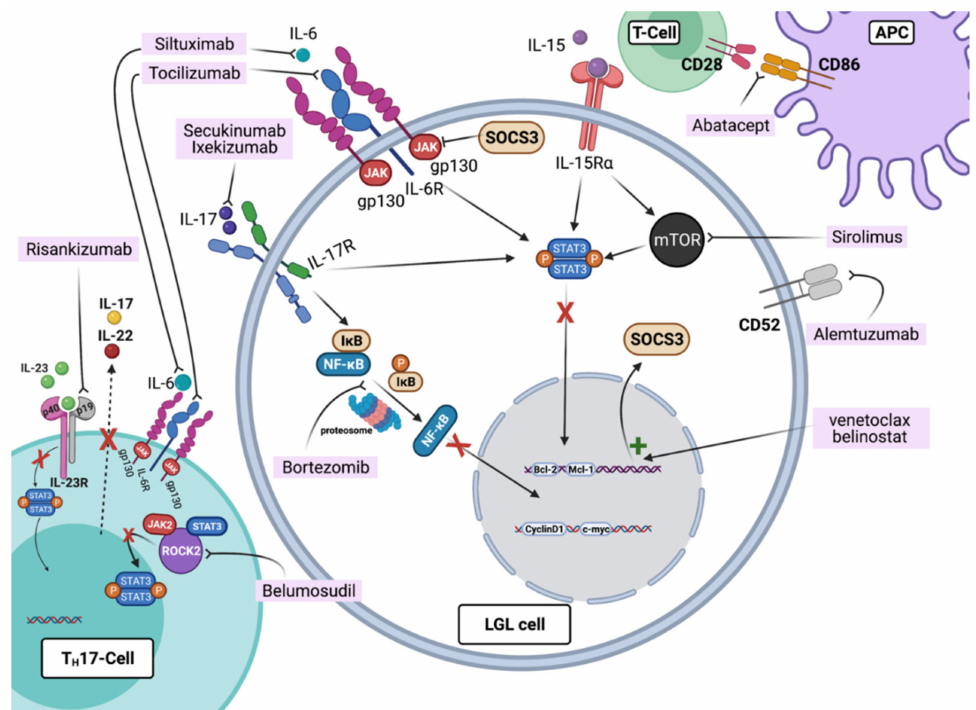
Figure 2. Pathways and agents described as having potential interest for the treatment of refractory LGLL. The humanized IgG1 Risankizumab is a mAB targeting the p19 subunit of IL-23 receptor and selectively inhibiting IL-23 and the STAT pathway, blocking IL-17 and IL-22 production. The ROCK2 inhibitor Belumosudil inhibits the STAT3 phosphorylation process. Anti-IL-6 mAB Tocilizumab and Siltuximab inhibit the JAK pathway by binding to the gp130 subunit. Secukinumab and Ixekizumab are anti-IL-17 mAB blocking the interaction with the IL-17 receptor with subsequent STAT3 and NF-kB pathway inhibition. Bortezomib is a proteasome inhibitor that downregulates the NF-kB pathway activity, ultimately blocking the degradation of different pro-apoptotic factors. Abatacept, by binding to CD80/CD86 on APC, blocks the CD28-mediated APC and T-cell interaction. Sirolimus is an inhibitor of the mammalian-Target of rapamycin ( mTOR ) kinase pathway, leading to cytokine-mediated T-cell activation and STAT3 inhibition. Alemtuzumab is anti-CD52, causing lymphocyte depletion through complement-medicated cell lysis and antibody-mediated cytotoxicity. Epigenetic modifiers such as Belinostat can restore SOCS3 expression, which results in STAT3 pathway inhibition. Figures were generated with BioRender.com (accessed on 20 August